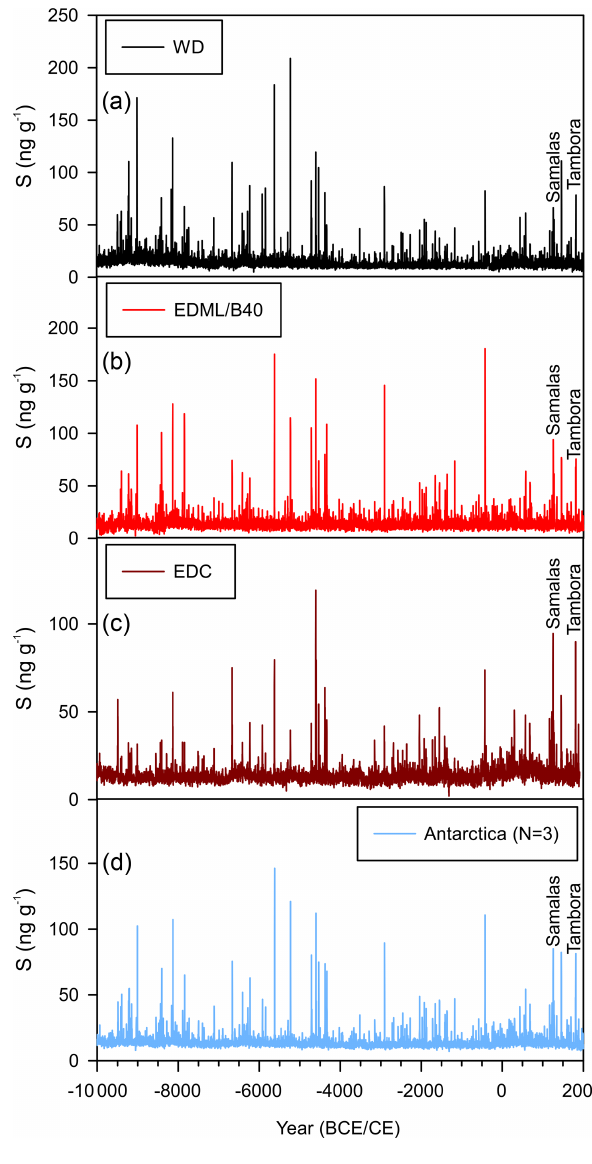
Figure 3. Holocene sulfur records from Antarctica: sulfur concen- tration records from the (a) WD, (b) EDML and (c) EDC ice cores as well as (d) a stack (“Antarctica” or ANT12k) of all three records for the Holocene (10000BCE–2000CE). Measured as sulfate, the EDML and EDC records are synchronized on the WD2014 chronol- ogy (Sigl et al., 2016), annualized and scaled to the WD record. The upper part from EDML is based on the 200m long B40 ice core drilled at the same site in 2012 (Sigl et al., 2015). Signals from two large historic eruptions, Tambora (1815) and Samalas (1257), are